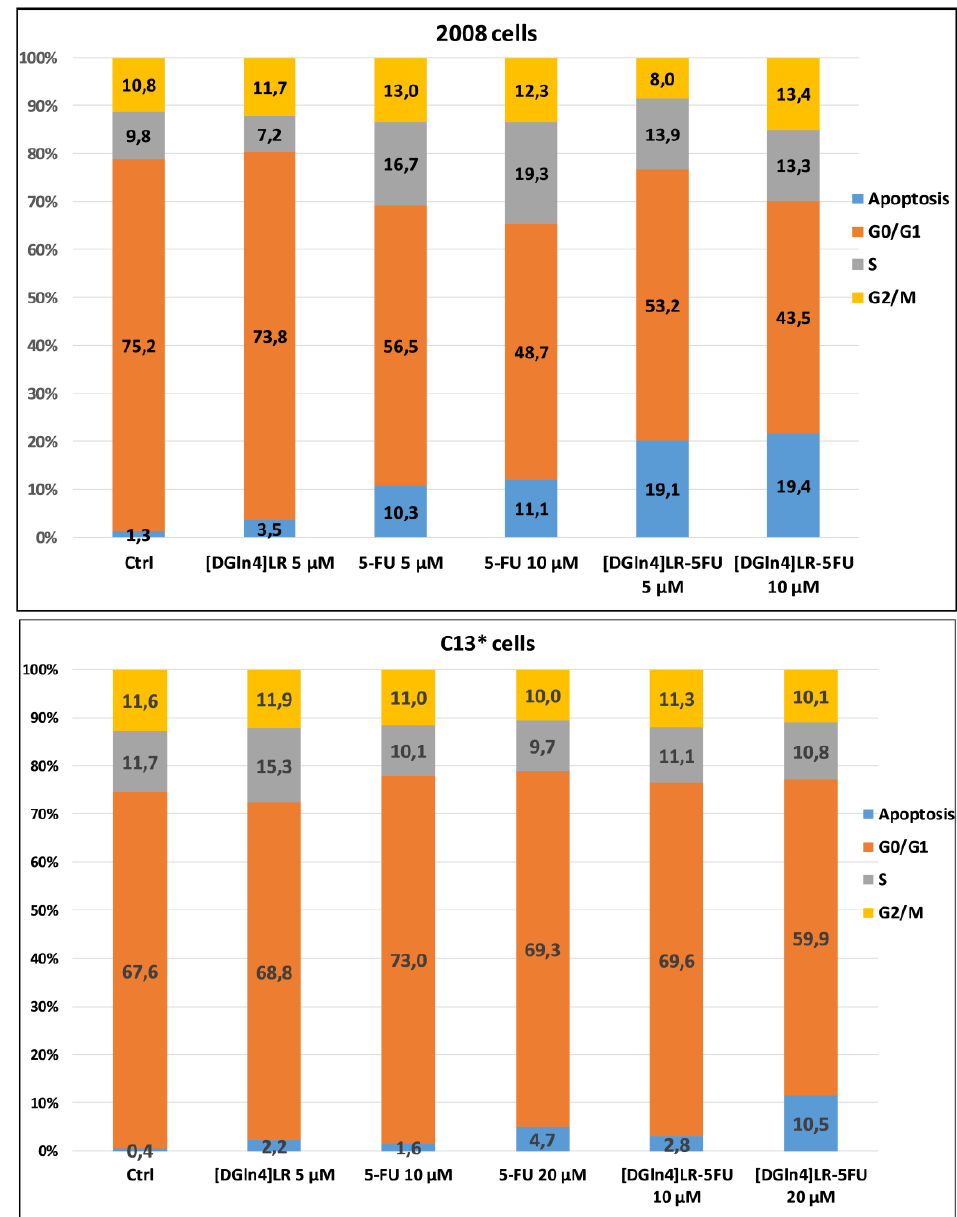
Figure 5. Effect of the [DGln4]LR peptide and 5-FU alone and in combination on the cell cycle phase distribution of 2008 and C13* cells by cytofluorimetric analysis of the DNA content by PI staining. After a 72 exposure to 5 µM [DGln4]LR and to the indicated concentrations of 5-FU alone or in concurrent combinations. Cells were processed according to methods described in Section 4. The inserted numbers indicate the percentages of cells in the different phases of the cell cycle and are the mean of two/three experiments. The error bars are omitted for a clearer visualization.